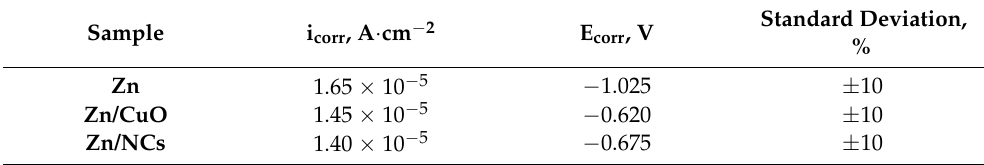
Table 3. Electrochemical parameters of the coatings after 55 days of immersion in a corrosion medium.